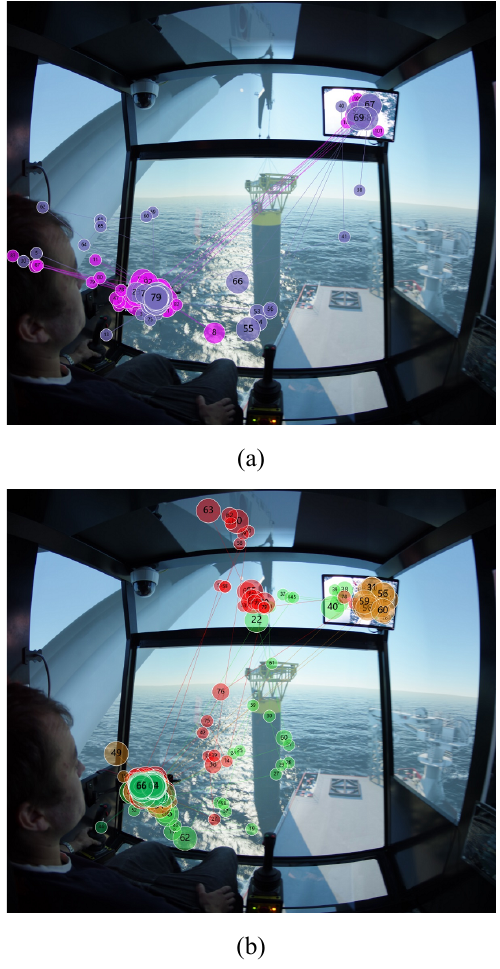
Figure 9: Scanpath for (a) experts and (b) novices in target stage